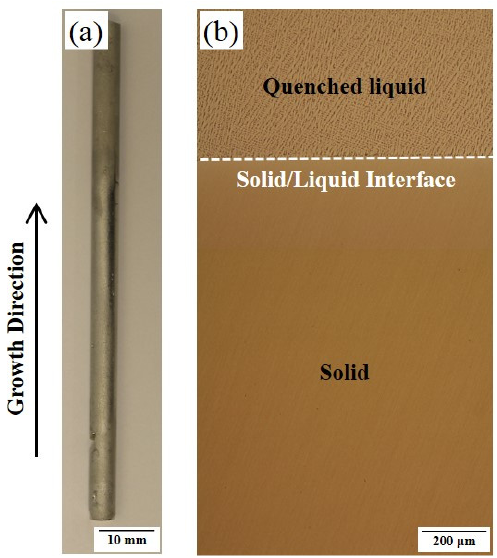
Figure 1. ( a ) Macroscopic image of DSQ specimen and ( b ) microstructure at the quenched solid/liquid interface region of the CoCrFeMnNi HEA. Table 1. Chemical compositions and partition coefficient ( k e ) observed at the solid/liquid interface region of HEAs (at %).